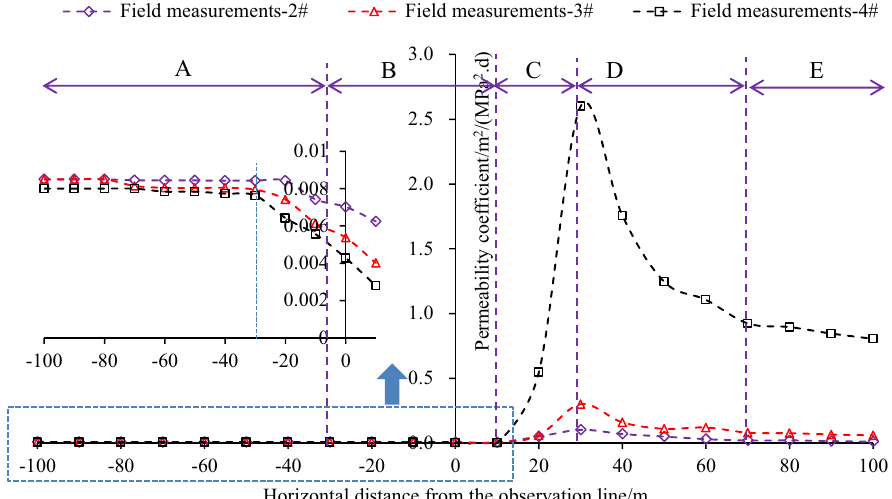
Figure 9. Permeability coefficient evolution during protective coal seam mining. A is In-situ stress zone, B is abutment stress influence zone, C is significant pressure-relief zone, D is gradually compacted zone, and E is compacted stable zone. In the figure, negative and positive of the x-axis mean the monitoring holes are located in front of and behind the longwall face, respectively.